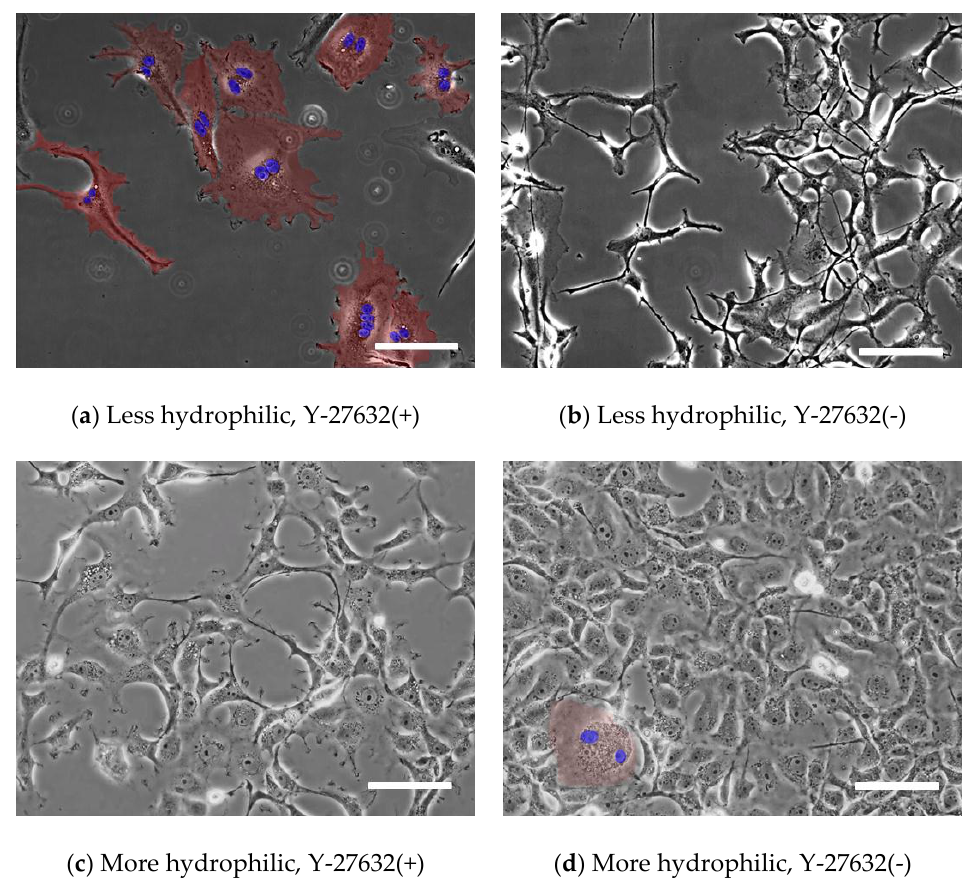
Figure 2. Typical images of XTC-YF cells seeded on ( a,b ) less hydrophilic (FPI) and ( c,d ) more hydrophilic (Matsunami) glass bottom dishes. Cells were incubated with ( a,c ) normal medium containing 100 µM Y-27632 and ( b,d ) normal medium alone. Multinucleate cells are shown in red and their nuclei are shown in blue. Scale bars represent 100 µm.